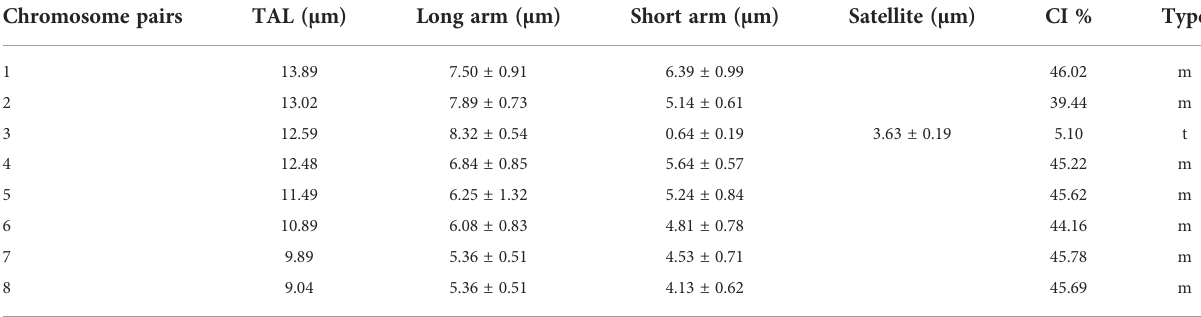
TABLE 2 Karyo-morphometric parameters of Allium sulaimanicum . Chromosome